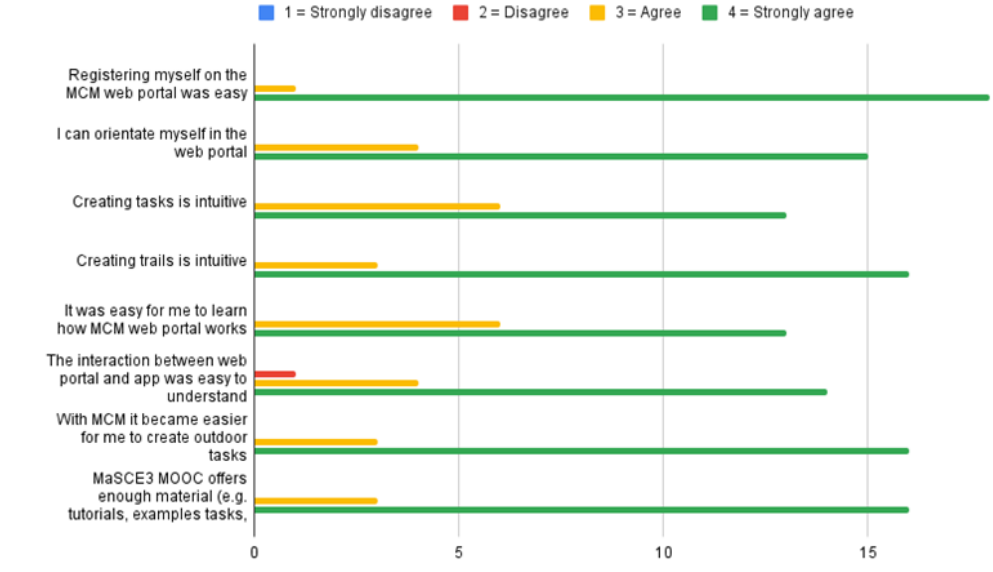
Figure 10. Teachers’ level of agreement with the statements related to the E → I process.